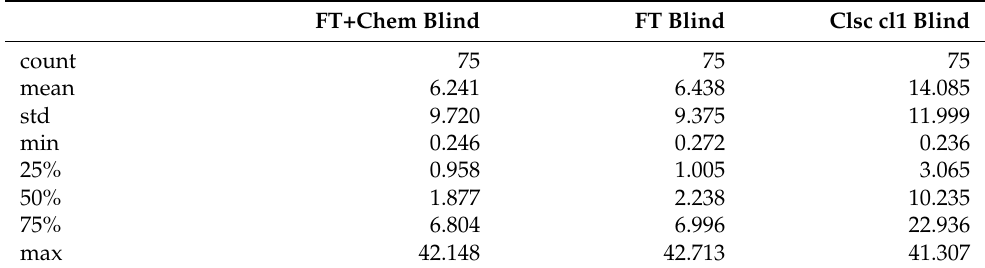
Table 5. Description of the distribution of RMSDs in each benchmarking protocol for Astex Diverse.